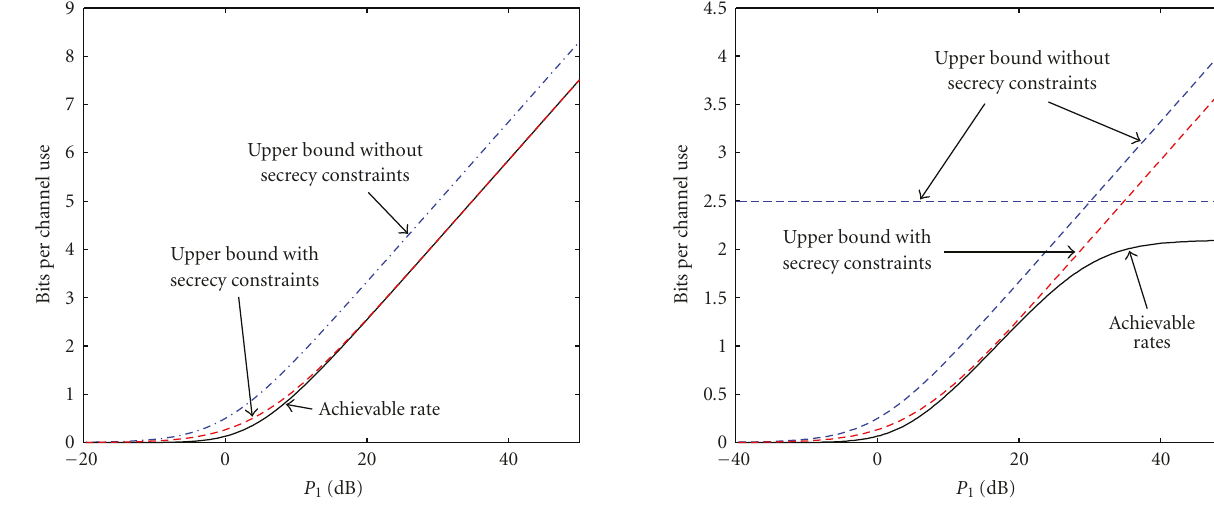
Figure 8: Secrecy Rate, P r = 30 dB, P 2 = 0 . 5 P 1 , α = 0 . 5 .